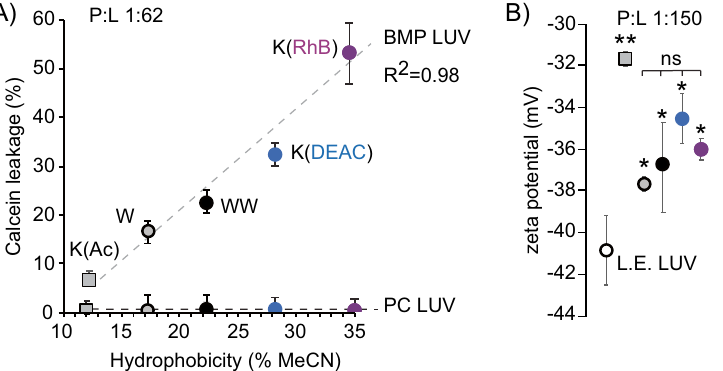
Figure 5. ( A ) Correlation between leakage assays and d(X)TAT hydrophobicity. Leakage assays were performed with calcein-loaded LUVs composed of zwitterionic lipids (PC LUV) or the anionic lipid BMP (BMP LUV). In all experiments, peptide to lipid ratio is 1:62. The data provided is the average and corresponding standard deviation of triplicate experiments. ( B ) Zeta potential of BMP LUVs in contact with d(X)TAT peptides, at a P:L of